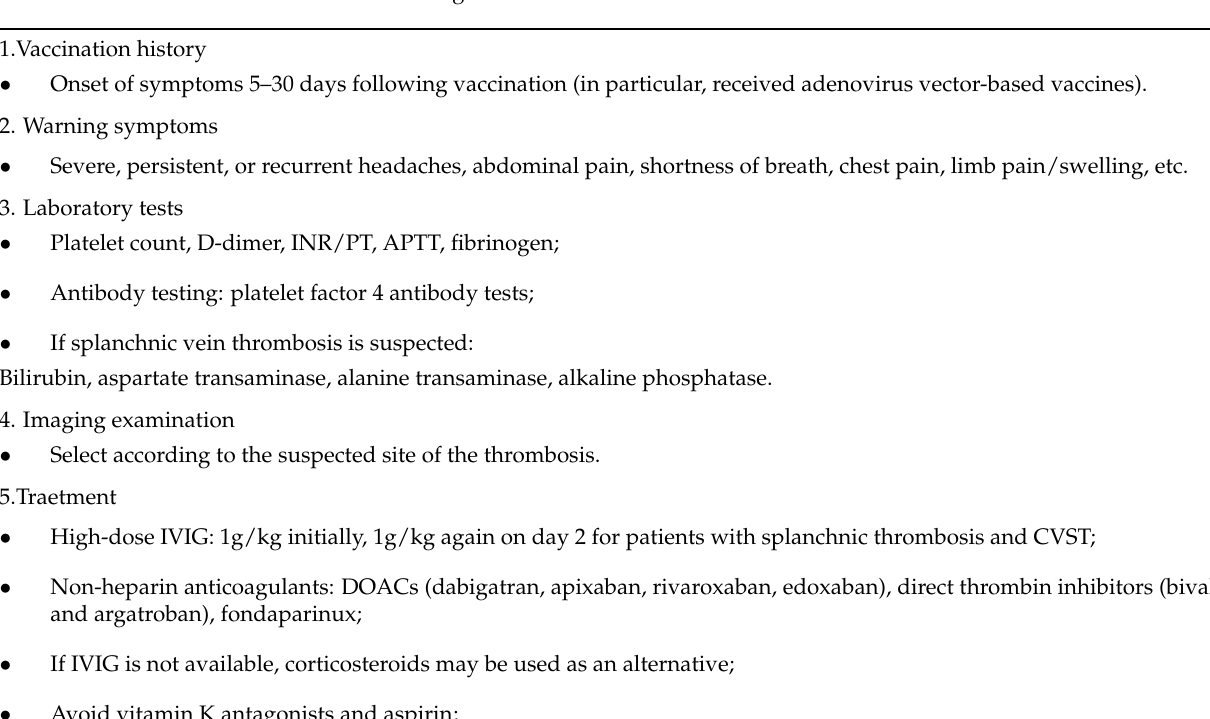
Table 2. Management of